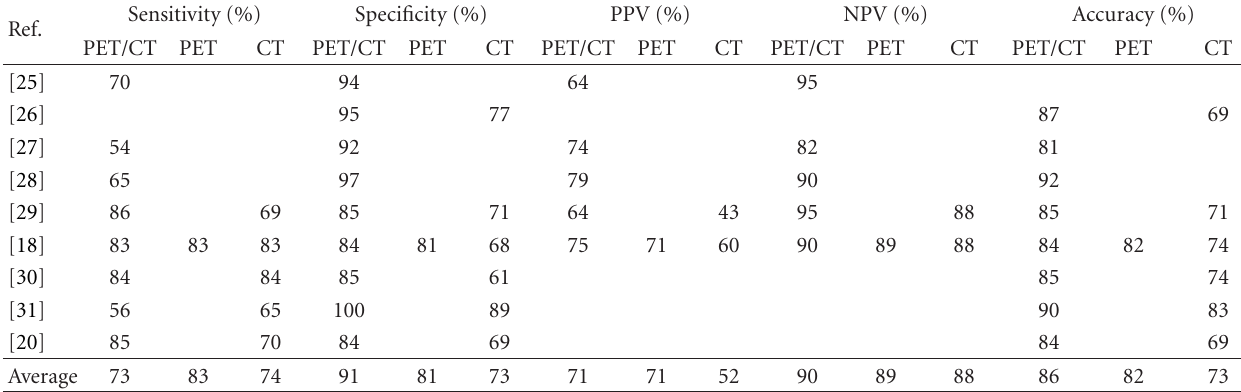
Table 1: Recent studies evaluating N staging with PET/CT compared with PET and CT.